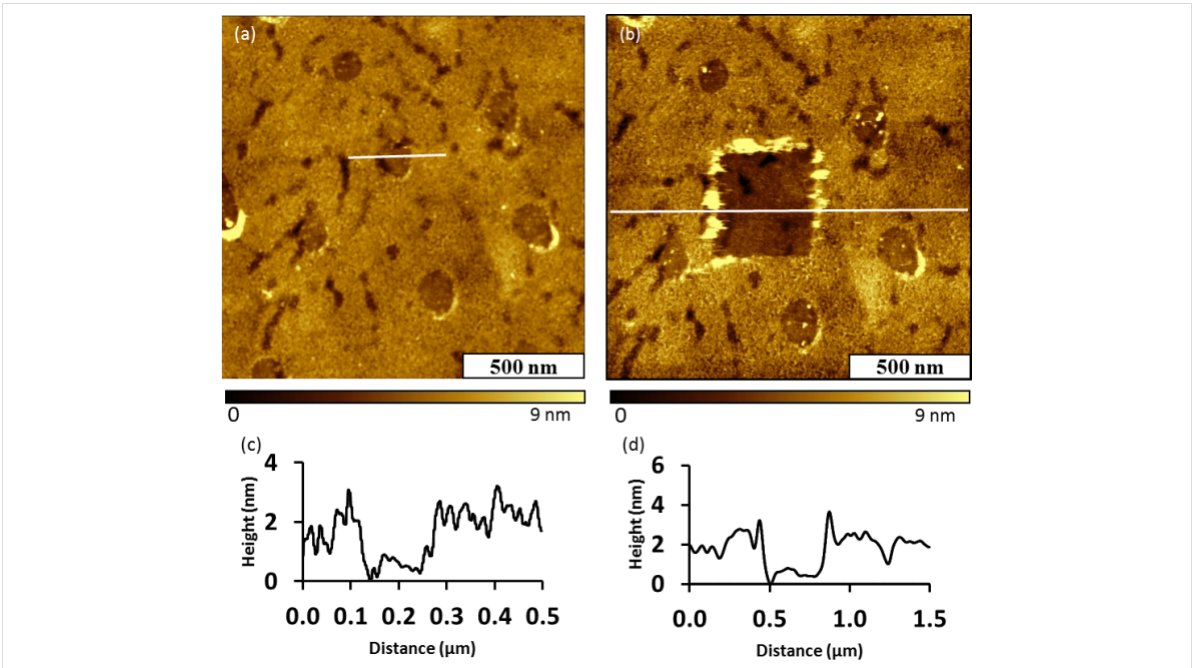
Figure 3: Au–Me thin film prepared in the absence of Ru(bpy) 3 Cl 2 was not robust. (a) Topography image of nanopores within the film; (b) topograph of a nanoshaved rectangular area; (c) cursor profile of an individual nanopore in (a); (d) cursor profile for the nanoshaved area in (b).